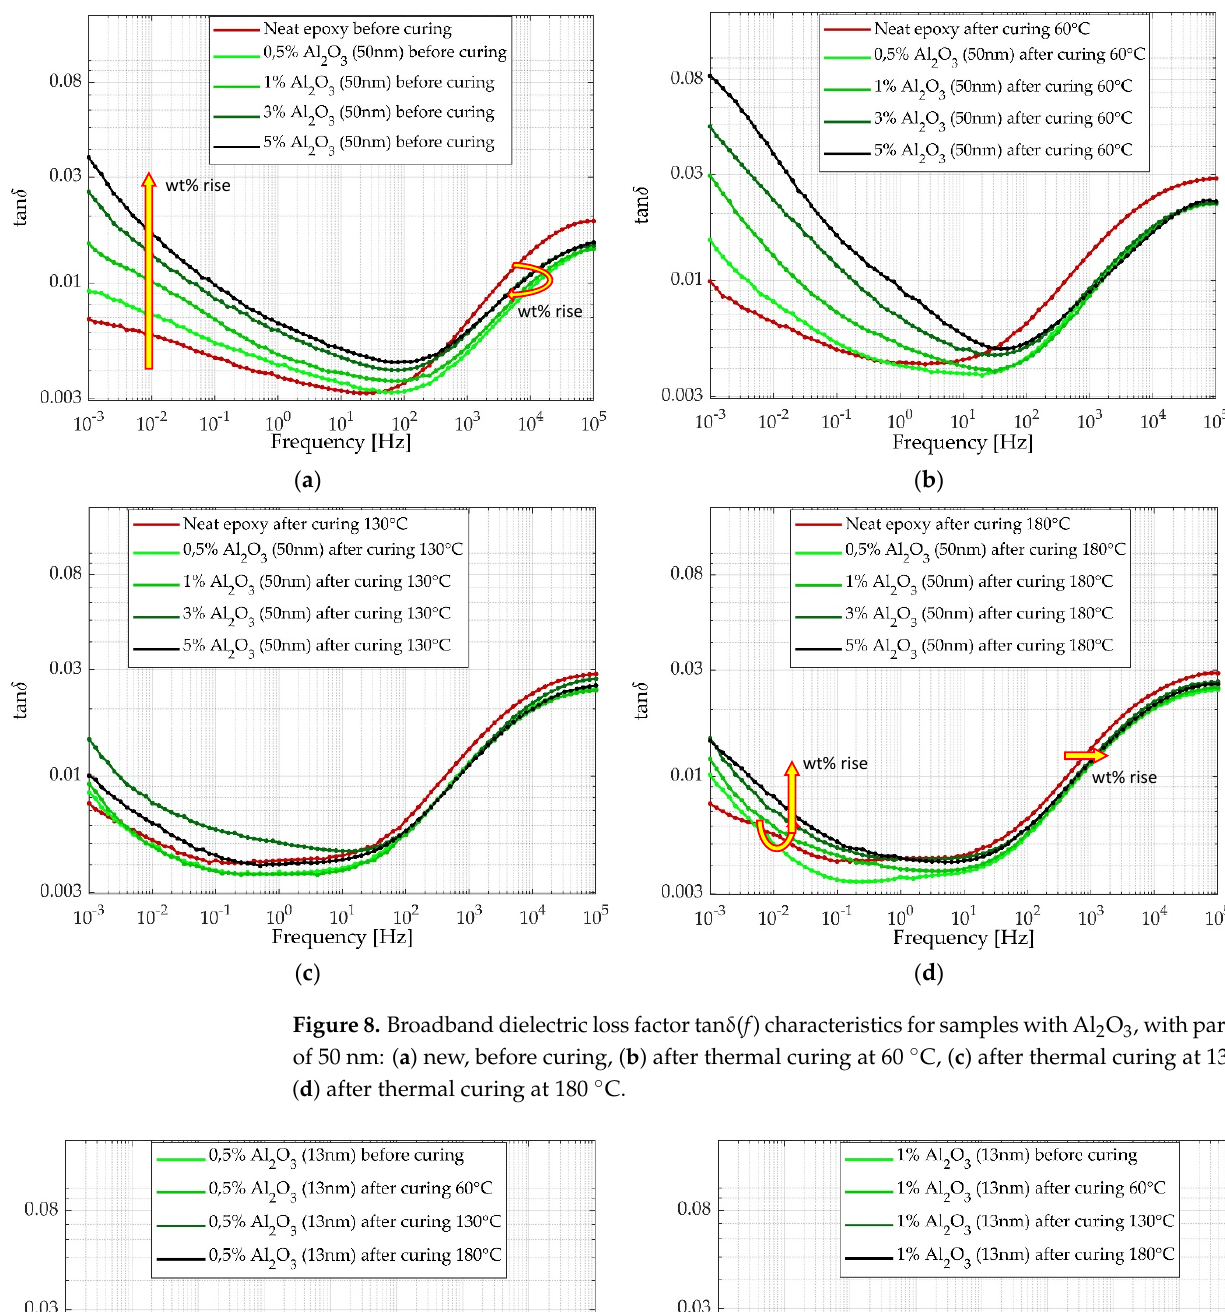
Figure 8. Broadband dielectric loss factor tan δ ( f ) characteristics for samples with Al 2 O 3 , with particles of 50 nm: ( a ) new, before curing, ( b ) after thermal curing at 60 °C, ( c ) after thermal curing at 130 °C, ( d ) after thermal curing at 180 °C.